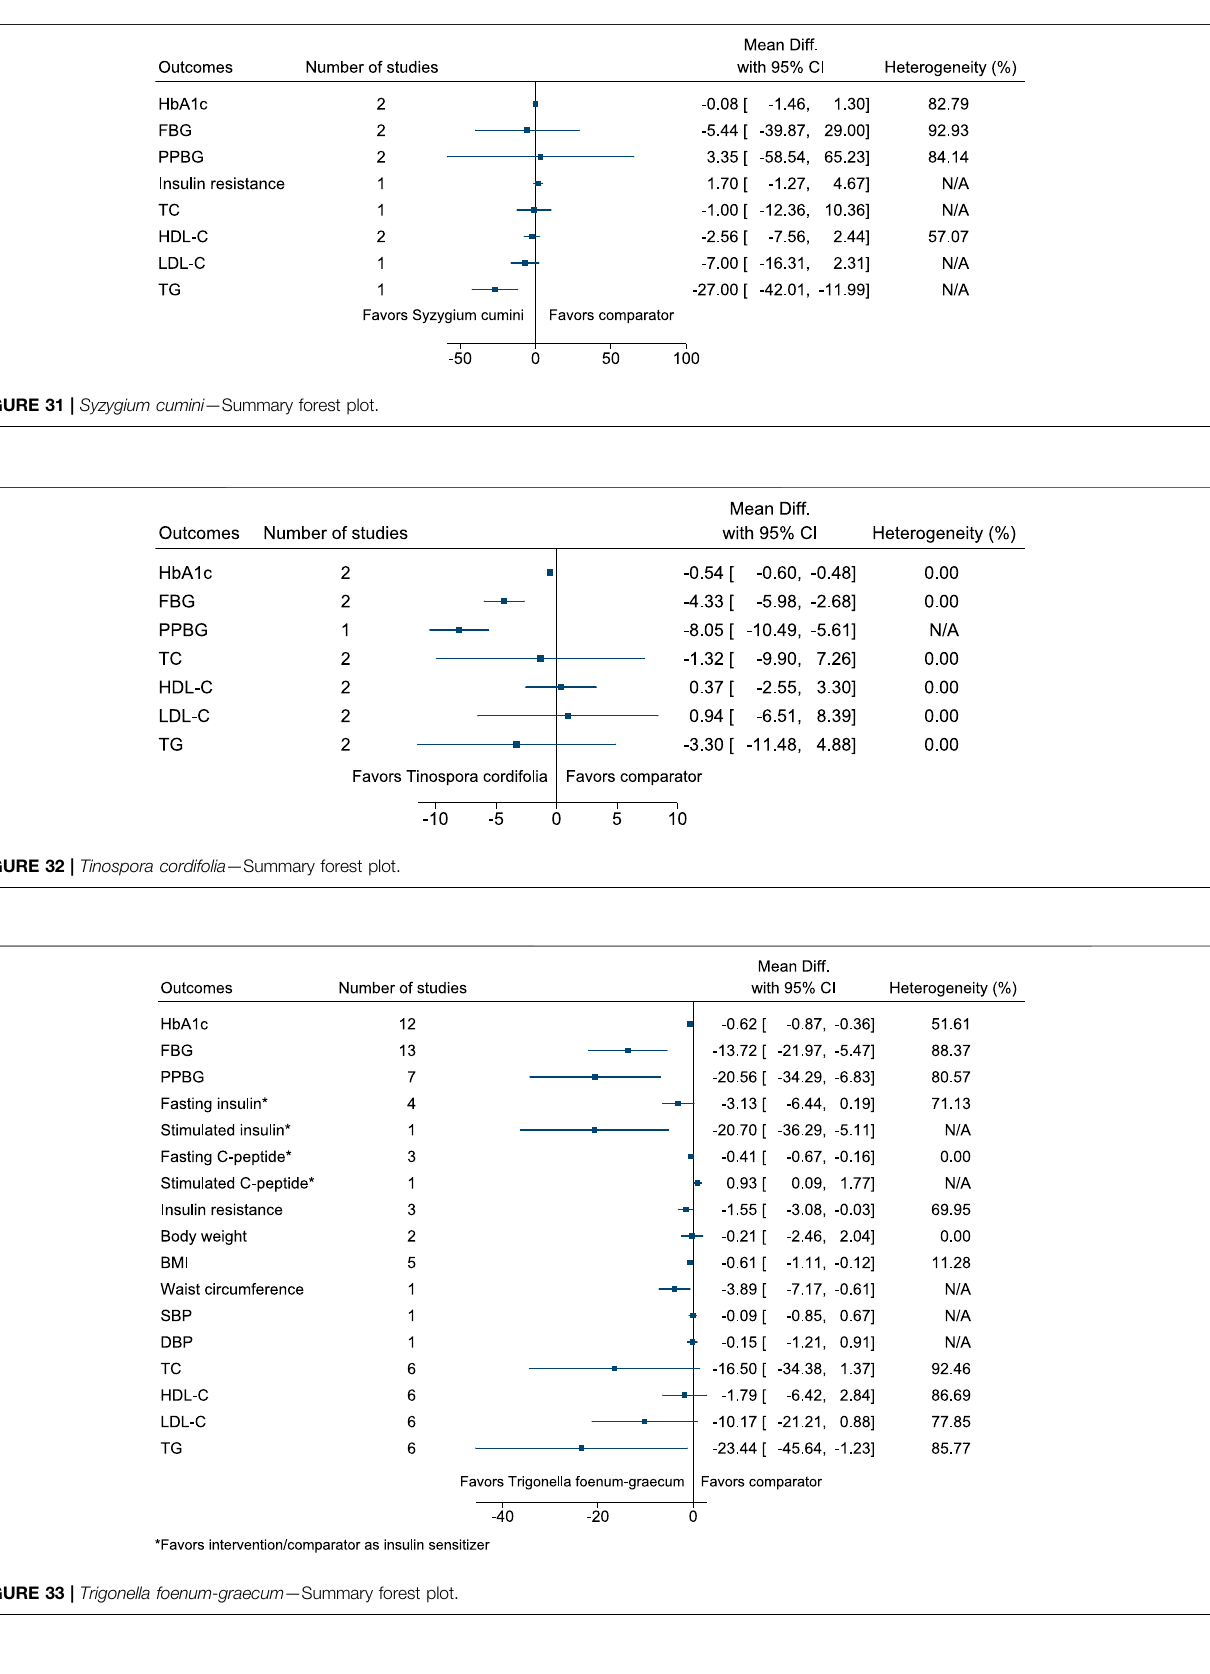
Frontiers in Pharmacology |